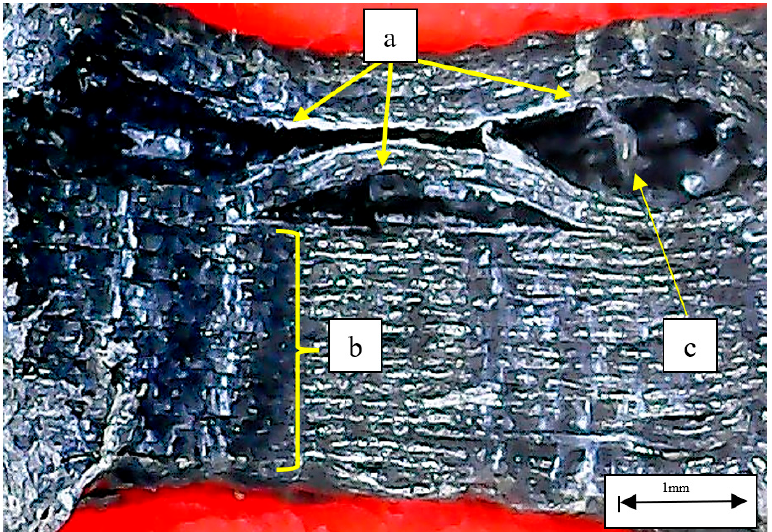
Figure 10. Central hole cross-section of NACA 633618 -CF_PLA-D sample: ( a ) delamination at the central hole; ( b ) damages caused by drilling; ( c ) bead-bridging mechanism.